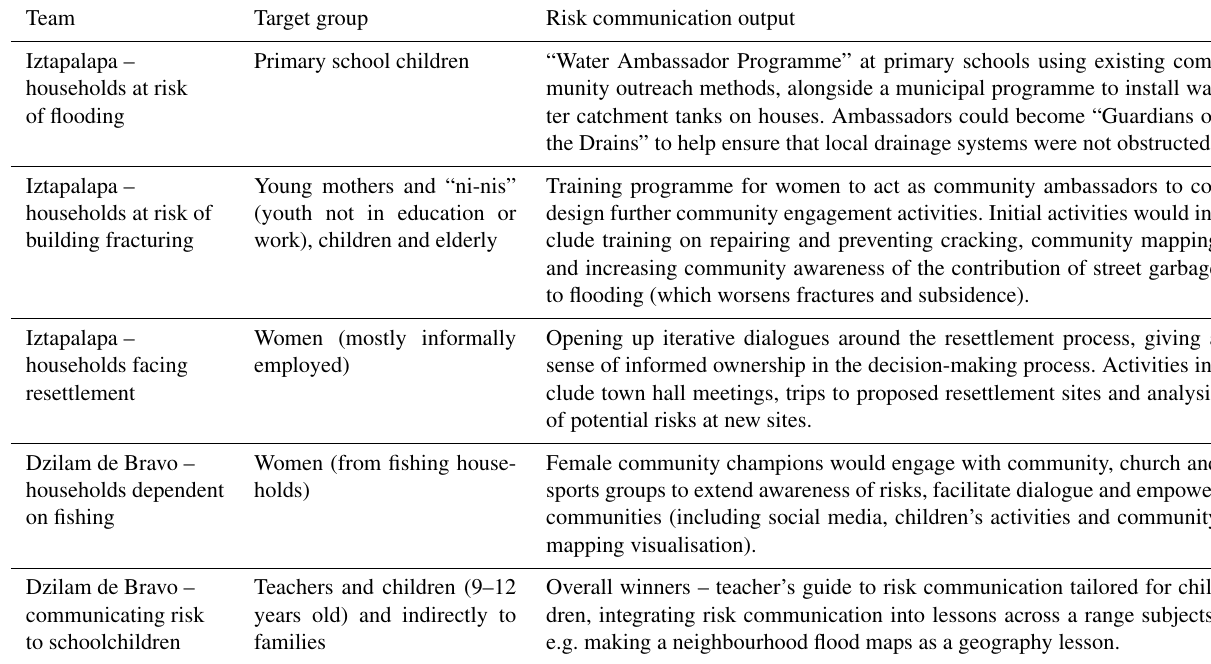
Table 2. Summary of teams’ results (edited tabulation of summary in Lickiss and Cumiskey, 2019). Team